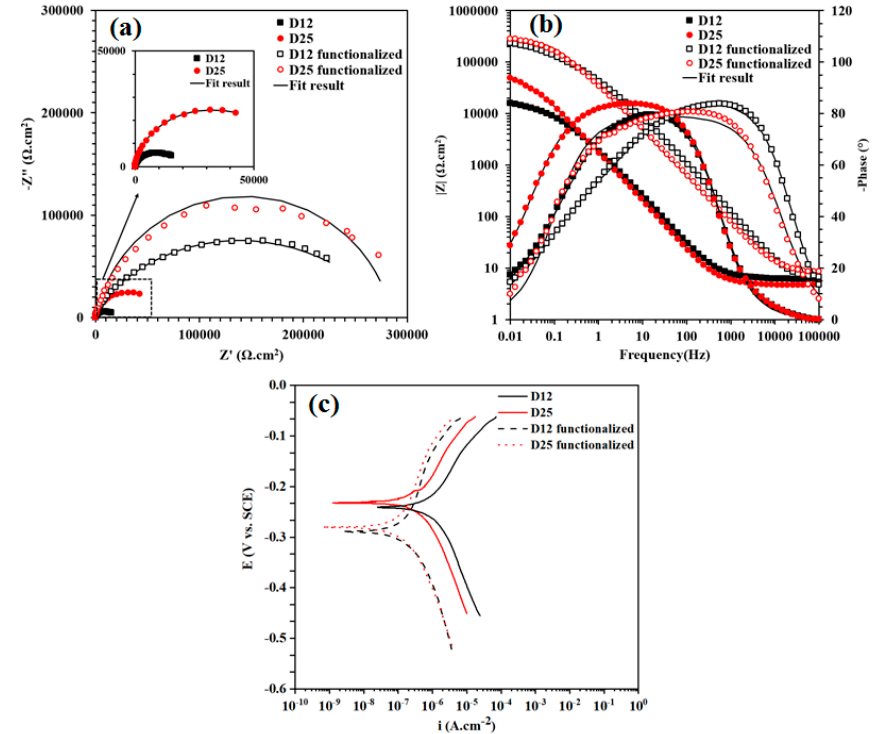
Figure 5. Electrochemical-impedance-spectroscopy (EIS) results for D12, D25, functionalized D12, and functionalized D25 samples exposed to 3.5% NaCl medium at 25 ± 1 °C. ( a ) Nyquist and ( b ) Bode (impedance modulus and phase-angle) representation. ( c ) Potentiodynamic-polarization curves of D12, D25, functionalized D12, and functionalized D25 in 3.5 wt % NaCl solution. Inset in ( a ), zoomed-in representation of area marked with dashed box.